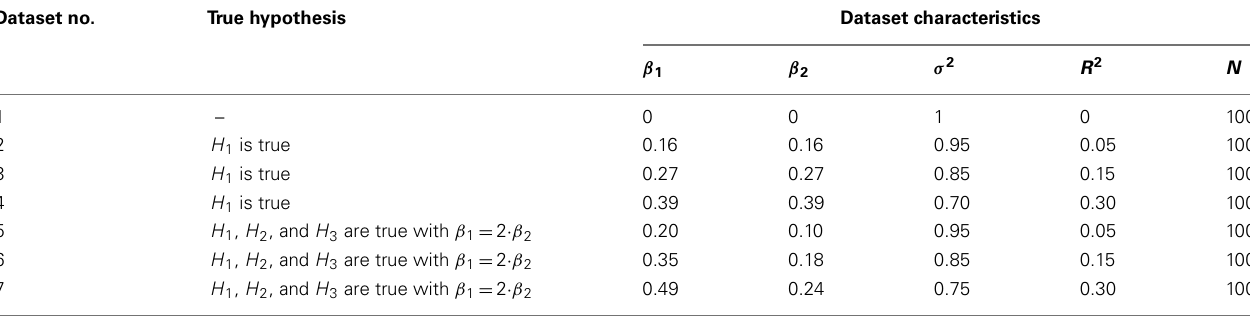
Table 1 |An overview of the seven generated datasets’ characteristics. Dataset